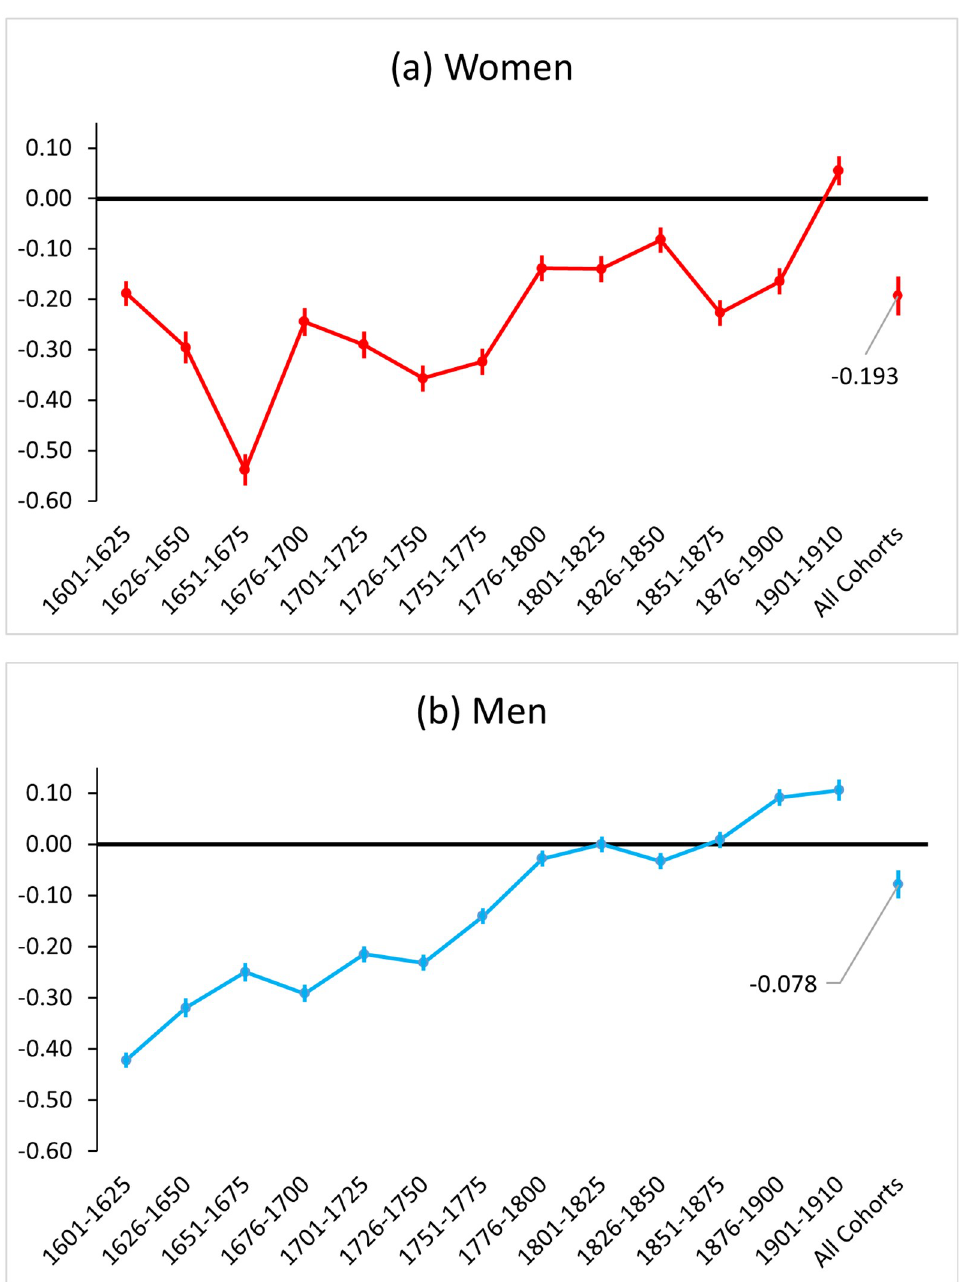
Fig 3. Effect of an additional child on parental lifespan (in years) by cohorts and sex. Point estimates of the fertility effects on lifespan with 95% confidence intervals are presented. Results are estimated using the female and male full samples and the FECS multilevel Tobit regression models, controlling for age at last birth and individuals’ place of birth.